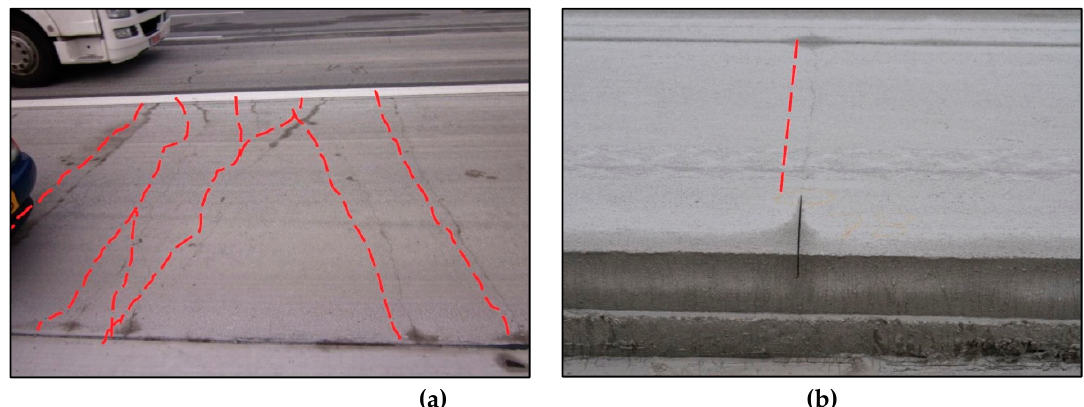
Figure 1. Development of crack pattern ( a ) E17 section ( b ) E313 section. Table 2. Crack survey data on the 313 test sections [12,22].